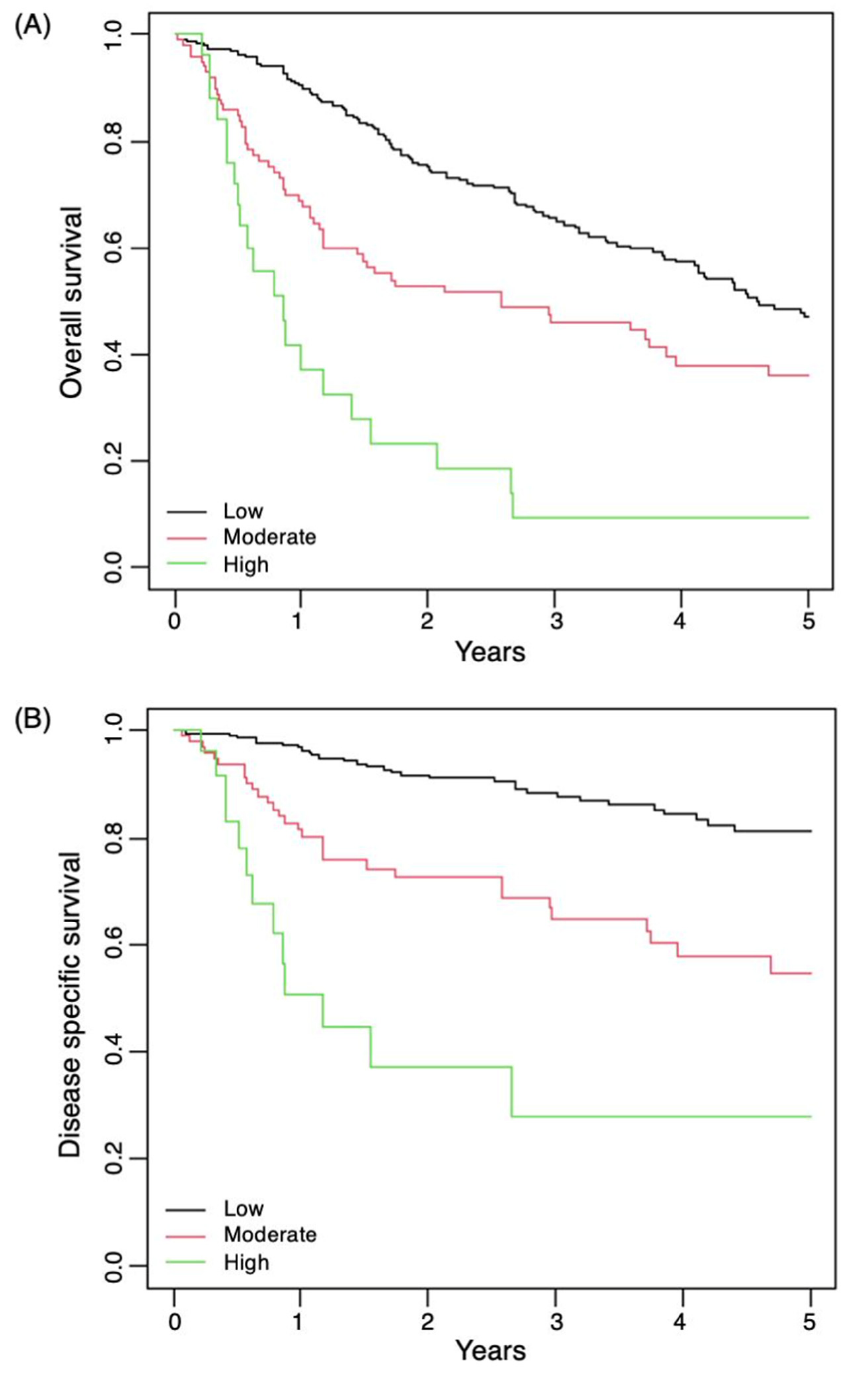
Figure 3. Kaplan–Meier curves with low, moderate, and high-risk groupings. ( A ) OS. ( B ) Figure 3. Kaplan – Meier curves with low, moderate, and high-risk groupings. ( A ) OS. ( B ) DSS.